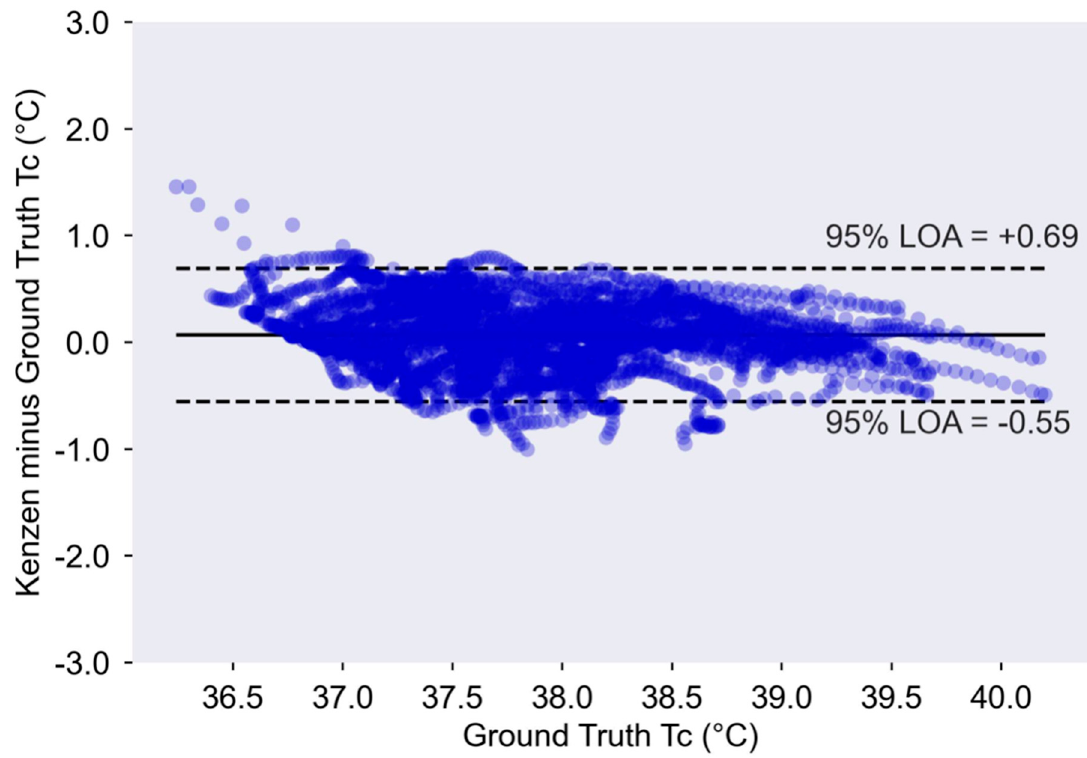
Figure 1. Modified Bland-Altman plot showing ground truth T C vs. Kenzen device T C . All 52 trials (i.e., 4036 min of data) are shown here. At T C ≤ 37.0 ◦ C, the Kenzen device slightly overestimates T C ; however, at T C ≥ 37.0 ◦ C, there is no discernable pattern in the residuals, and the algorithm meets pre-established accuracy criteria compared to ground truth T C . The 95% LOA on the figure include the mean bias (i.e., mean bias ± 1.96 × SD). Mean bias = 0.07 ◦ C.